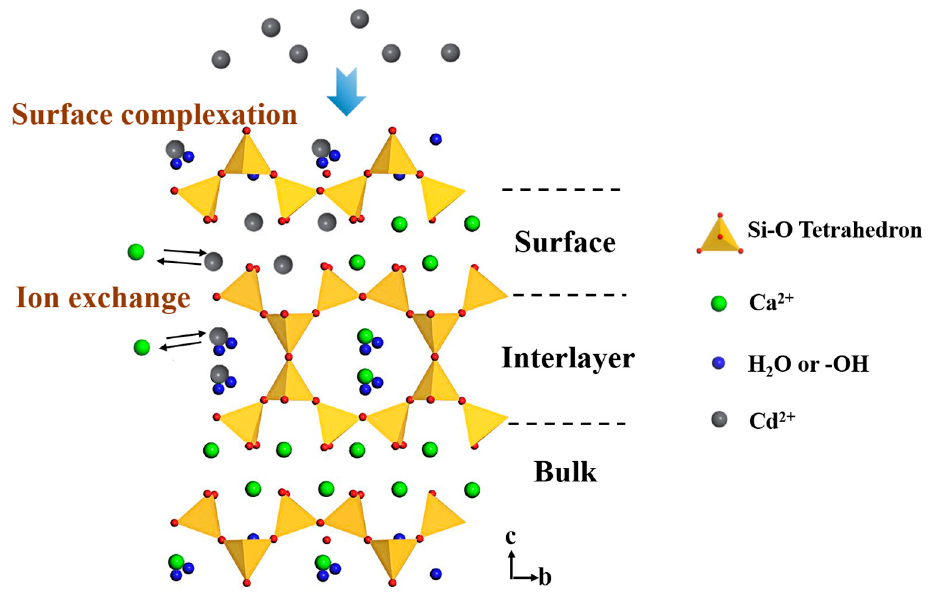
Figure 10. Mechanism of Cd 2+ removal using tobermorite.